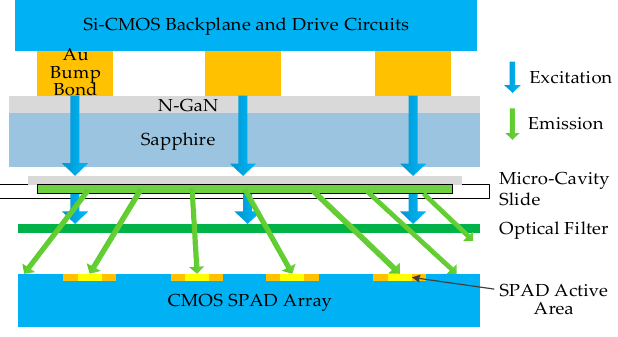
Figure 6. The cross section of the integrated time-gated fluorescence microsystem. The fluorescent sample is sandwiched between a micro-cavity slide and a cover slip. The long-pass filter eliminates the excitation light. © (2010) IEEE. Adapted, with permission, from [34].